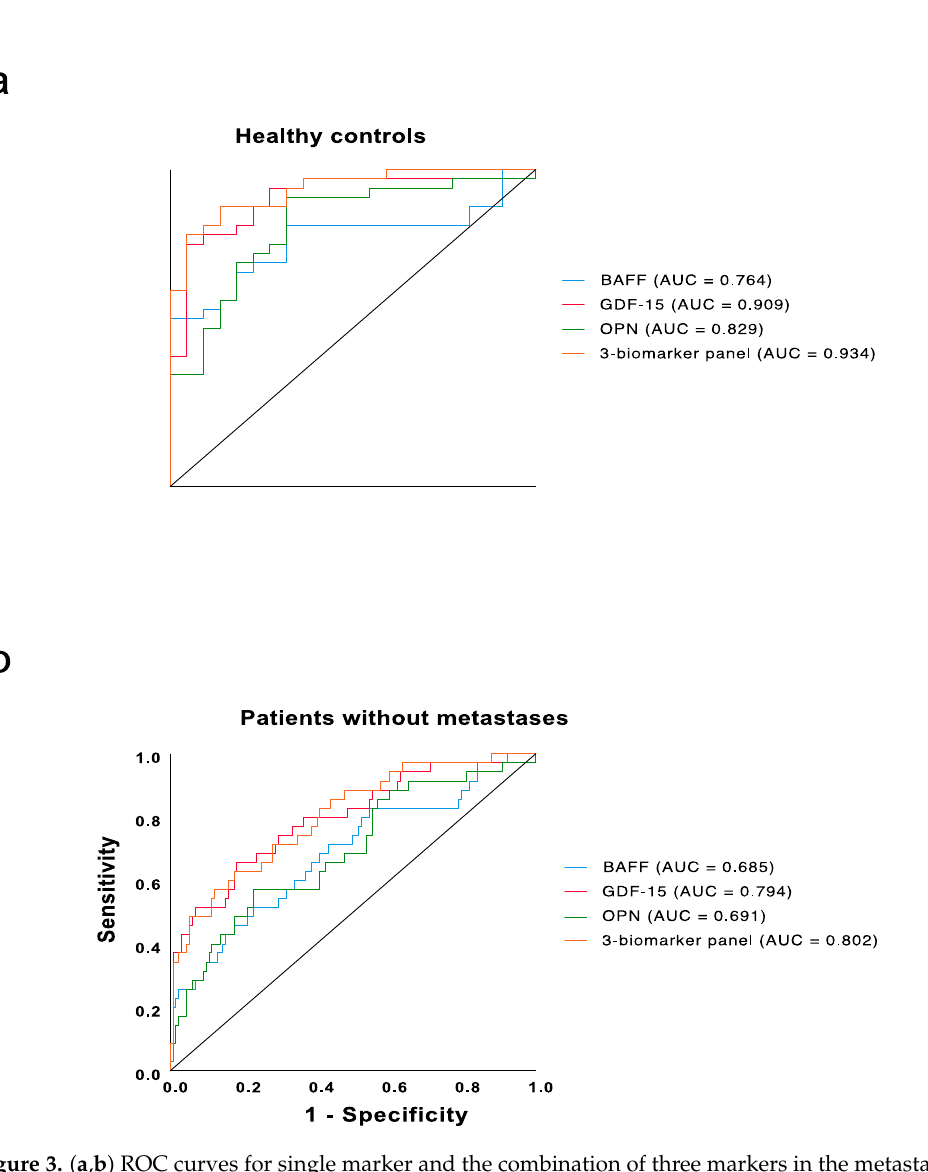
Figure 3. ( a , b ) ROC curves for single marker and the combination of three markers in the metastatic UM patients compared with healthy individuals and UM patients without metastases, re- spectively.